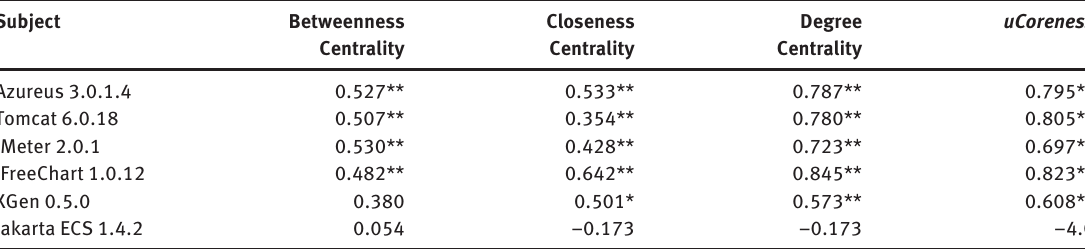
Table 4. Rank Correlation between wCoreness and Other Four Centrality Metrics Using Kendall’s Tau-b.